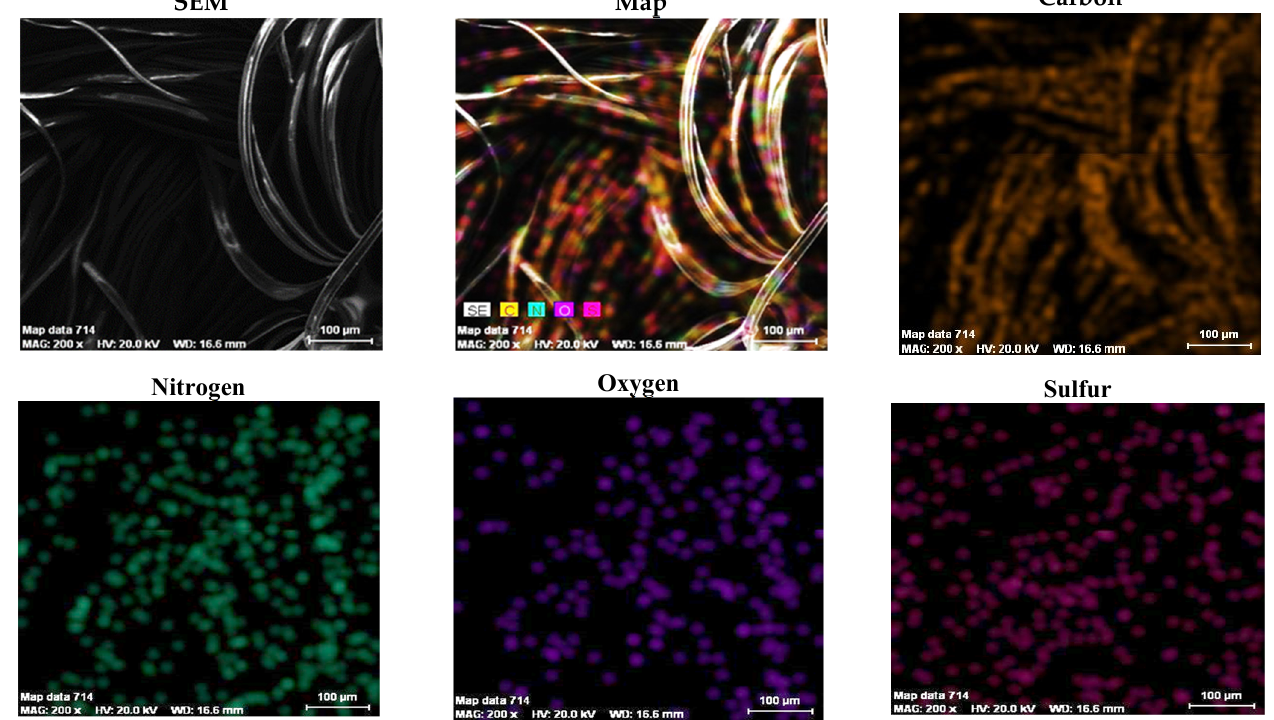
Figure 11. SEM image and elements mapping of untreated Dralon L fibers.